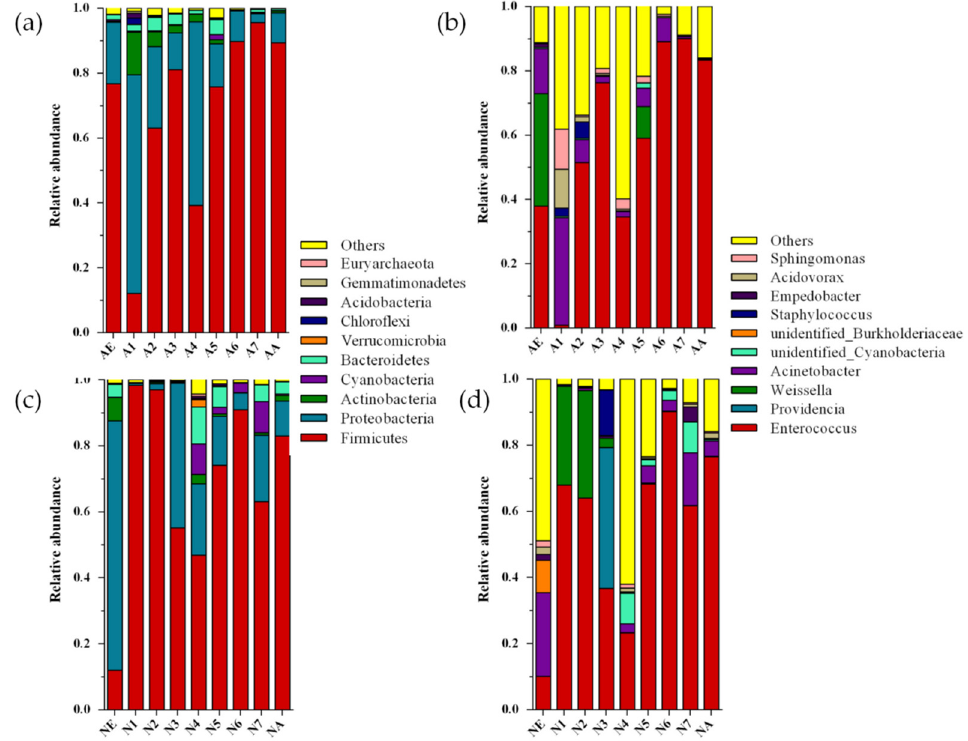
Figure 2. The relative abundance of bacteria in the gut microbiota from L. xylina fed different diets, at the phylum and genus levels: ( a ) at the phylum level for L. xylina fed on SAC; ( b ) at the phylum level for L. xylina fed on NSC; ( c ) at the genus level for L. xylina fed on SAC; ( d ) at the phylum level for L. xylina fed on NSC. Note: A1–A7: the first to seventh instars for larvae of L. xylina under the SAC treatment; N1–N7: the first to seventh instars for larvae of L. xylina under the NSC treatment.